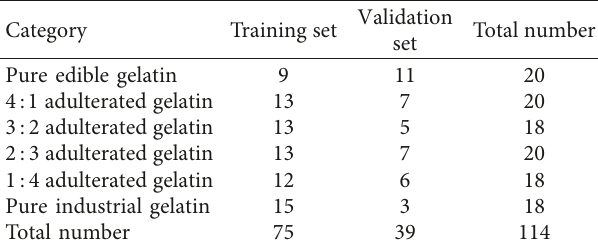
Figure 1: Mean values and standard deviations of NIR spectra for each group of gelatin before and after preprocessing. Table 1: Training set and validation set of gelatin samples with six different adulteration